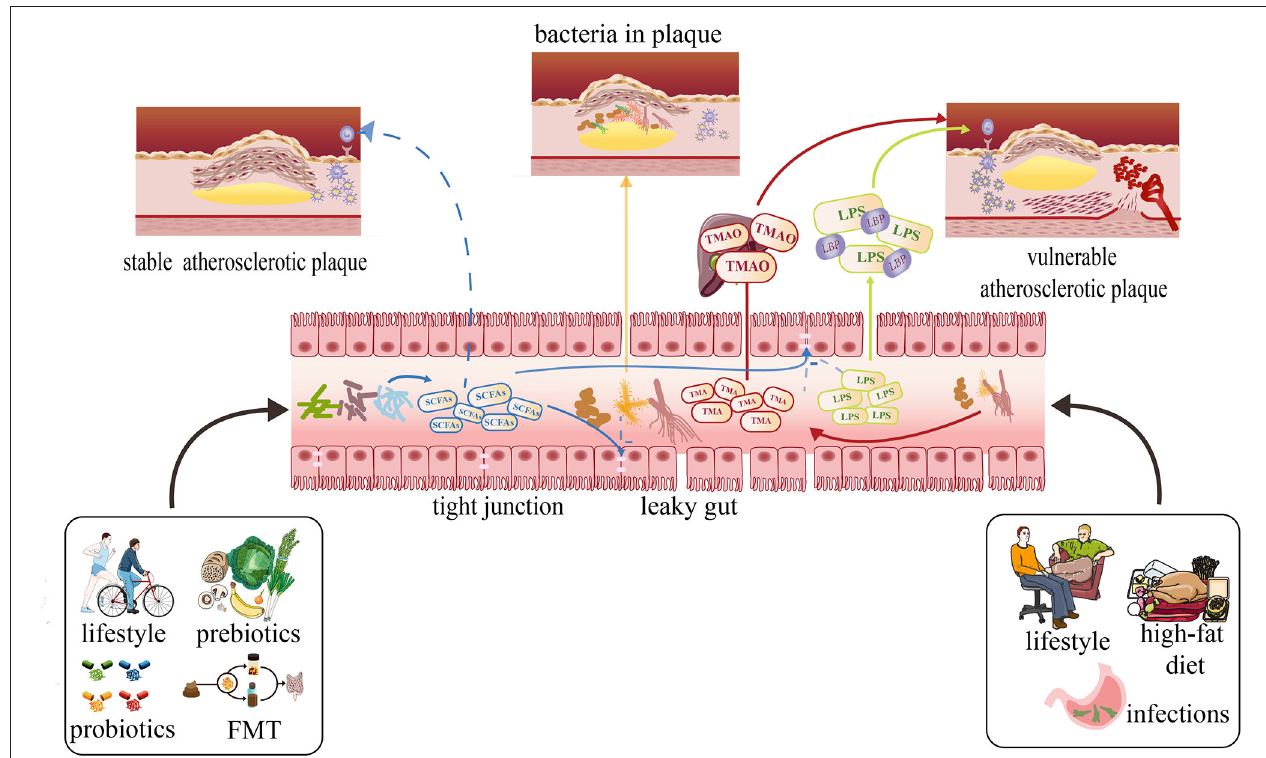
FIGURE 2 | Effects of metabolites produced by the gut microbiota on atherosclerosis and possible therapies focusing on the gut microbiota to prevent atherosclerosis development and stabilize plaque. A healthy lifestyle usually can cause SCFAs to increase with related bacteria increasing. The SCFAs can protect gut barrier by supporting tight junctions to inhibit translocation of LPS, TMAO, and other damaging metabolites into the circulation. They also can prevent the development of atherosclerosis and stabilize the plaque. The high-fat diet, sedentary lifestyle may cause the plasma concentrations of TMAO and LPS to increase by increasing some kinds of bacterium and intestinal permeability, which can make the plaque more